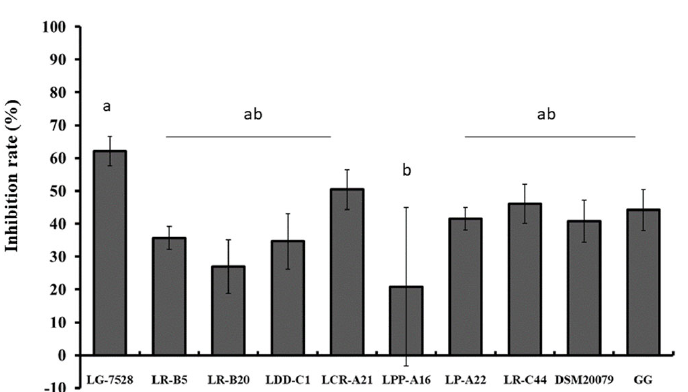
Figure 2. Inhibition (%) of L. monocytogenes EGDe adhesion to the Caco-2 cells by different lactobacilli strains in a competition assay, where the antagonistic bacteria were added to the epithelial cells at the same time. Data represent the mean values ± standard error of the mean (SEM) of three biological and two technical replicates. Different letters indicate significant differences among the strains ( p <